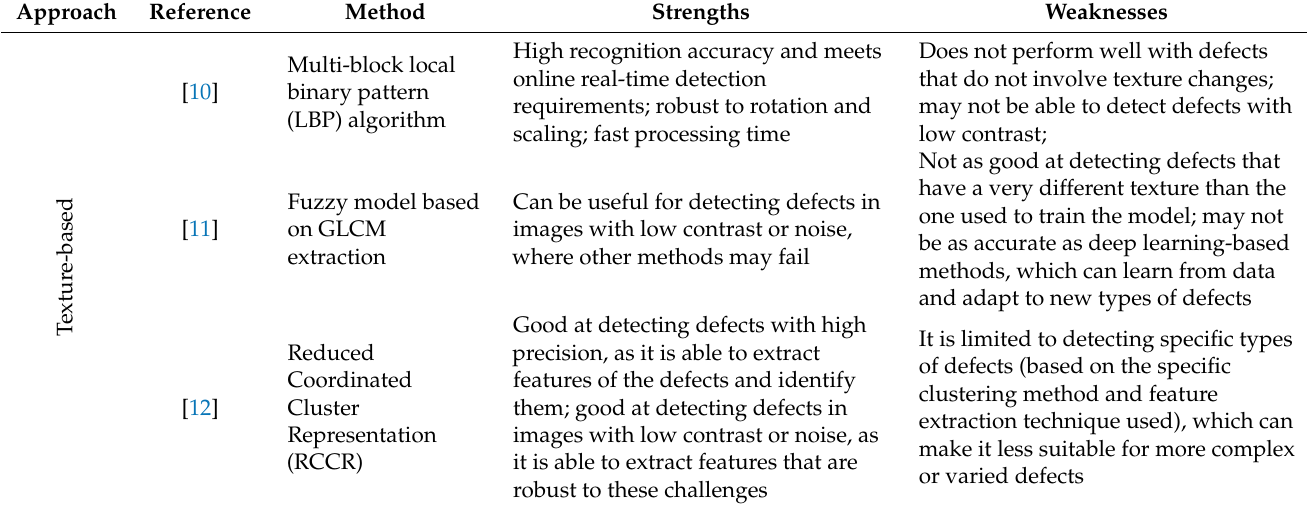
Table 2. An overview of the strengths and weaknesses of various feature-based methods for detecting surface defects in industrial